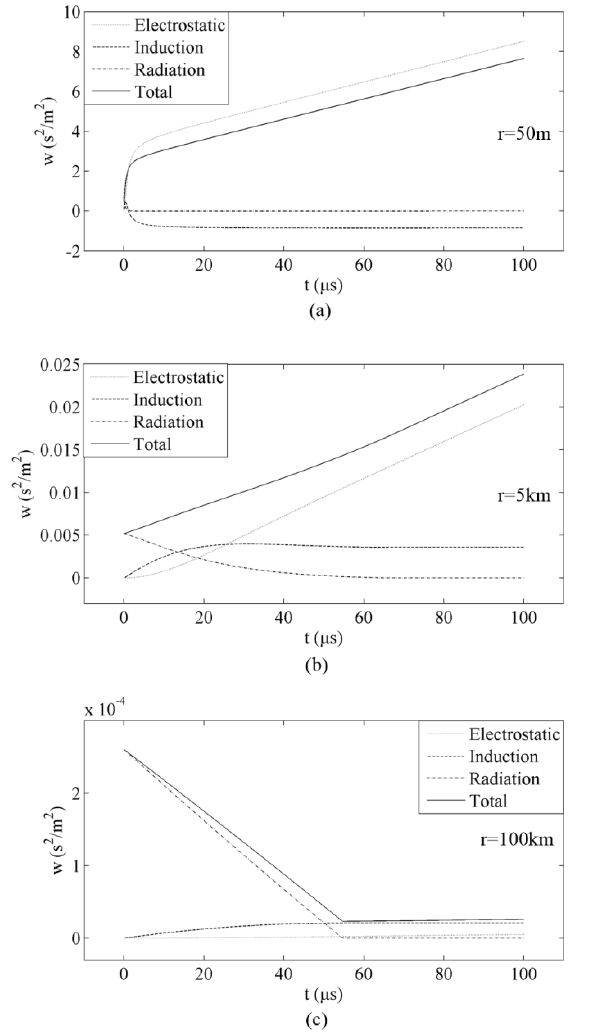
Figure 3. Components of transformation function at: ( a ) close, ( b ) intermediate, and ( c ) far range from the lightning channel.